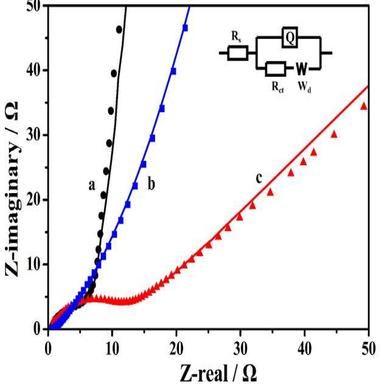
Nyquist plots of ERGQDs/PPy-2/GCE (a), ERGQDs/GCE (b) and PPy-2/GCE (c). Inset is the corresponding equivalent circuit, where Rs represents the ohmic resistance of electrolyte and the internal resistance of electrode, Rct represents the charge transfer resistance, Wd represents the Warburg resistance, and Q represents the constant phase element.